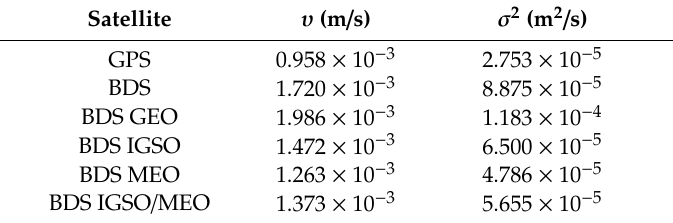
Table 1. The statistics of the change rate υ and power spectral density σ 2 on DOY 69–75, 2015.